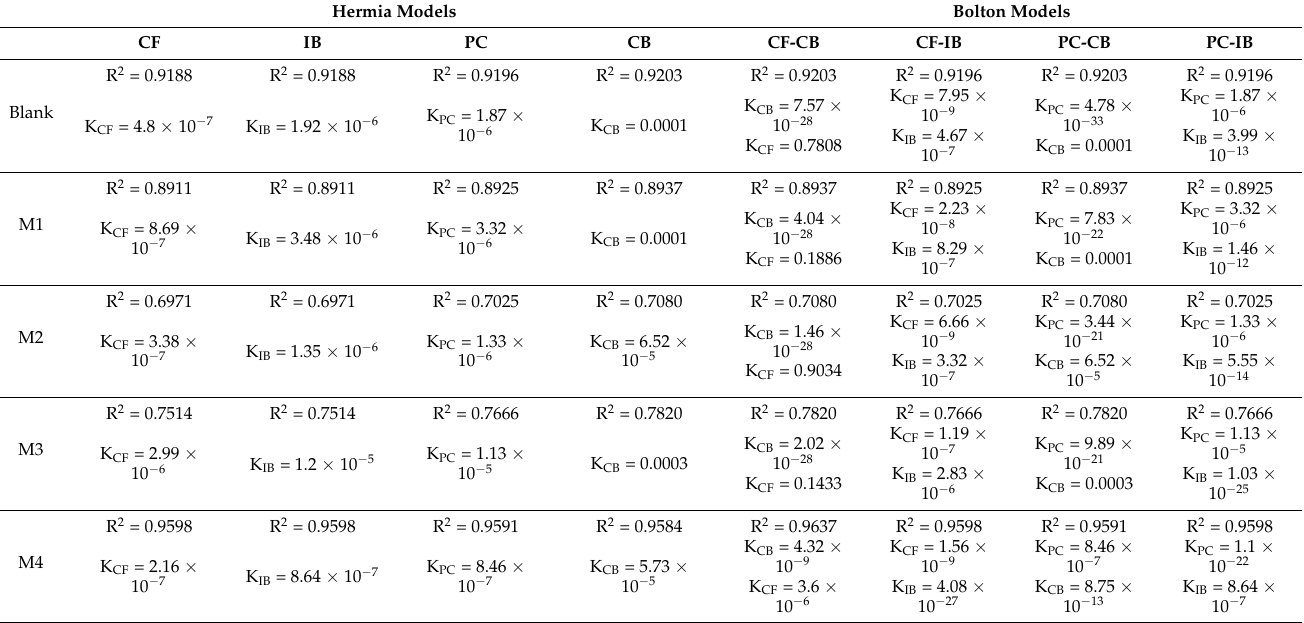
Table 9. The R 2 and estimated K values of the membrane samples for the Hermia and Bolton models. Hermia Models Bolton